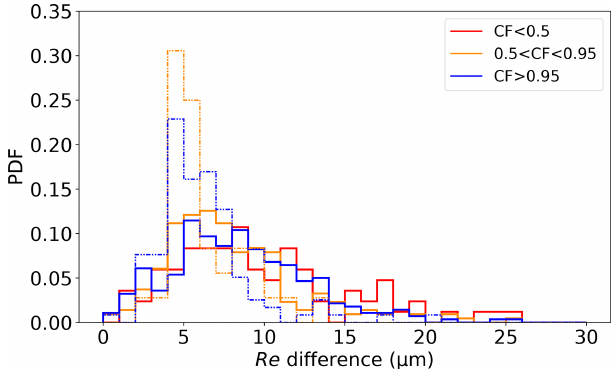
Figure 9. PDF of the R e difference stratified by CF < 0.5 (11% of all cloud elements), 0.5 < CF < 0.95 (34% of all cloud elements), and CF > 0.95 (54% of all cloud elements) for cloud elements with transect lengths less than 2km (79% of all cloud elements, solid) and greater than 2km (21% of all cloud elements, dashed). There are no samples for CF < 0.5 for transect lengths greater than